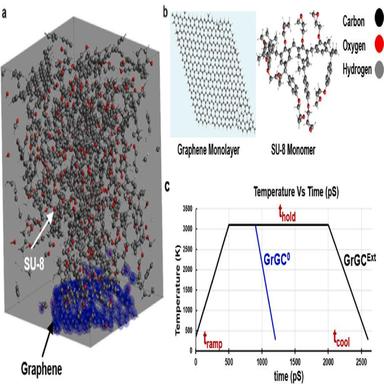
(a) Molecular dynamics (MD) model with simulation box of 34 Å x 34.1 Å x 34 Å size containing Gr monolayer (in blue color) and 20 crosslinked SU-8 monomers, (b) Gr monolayer and SU-8 monomer, a precursor for GC, (c) temperature profile for simulation. In GrGCExt, thold = 1500 ps and ttotal = 2600 ps. In GrGC0 , thold = 400 ps and ttotal = 1200 ps. The position of Gr layer matches conditions at pyrolysis. (A colour version of this figure can be viewed online.)